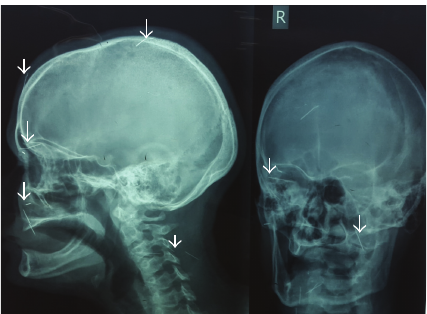
Figure 1: Skull X-ray showing at least eleven needles (some are